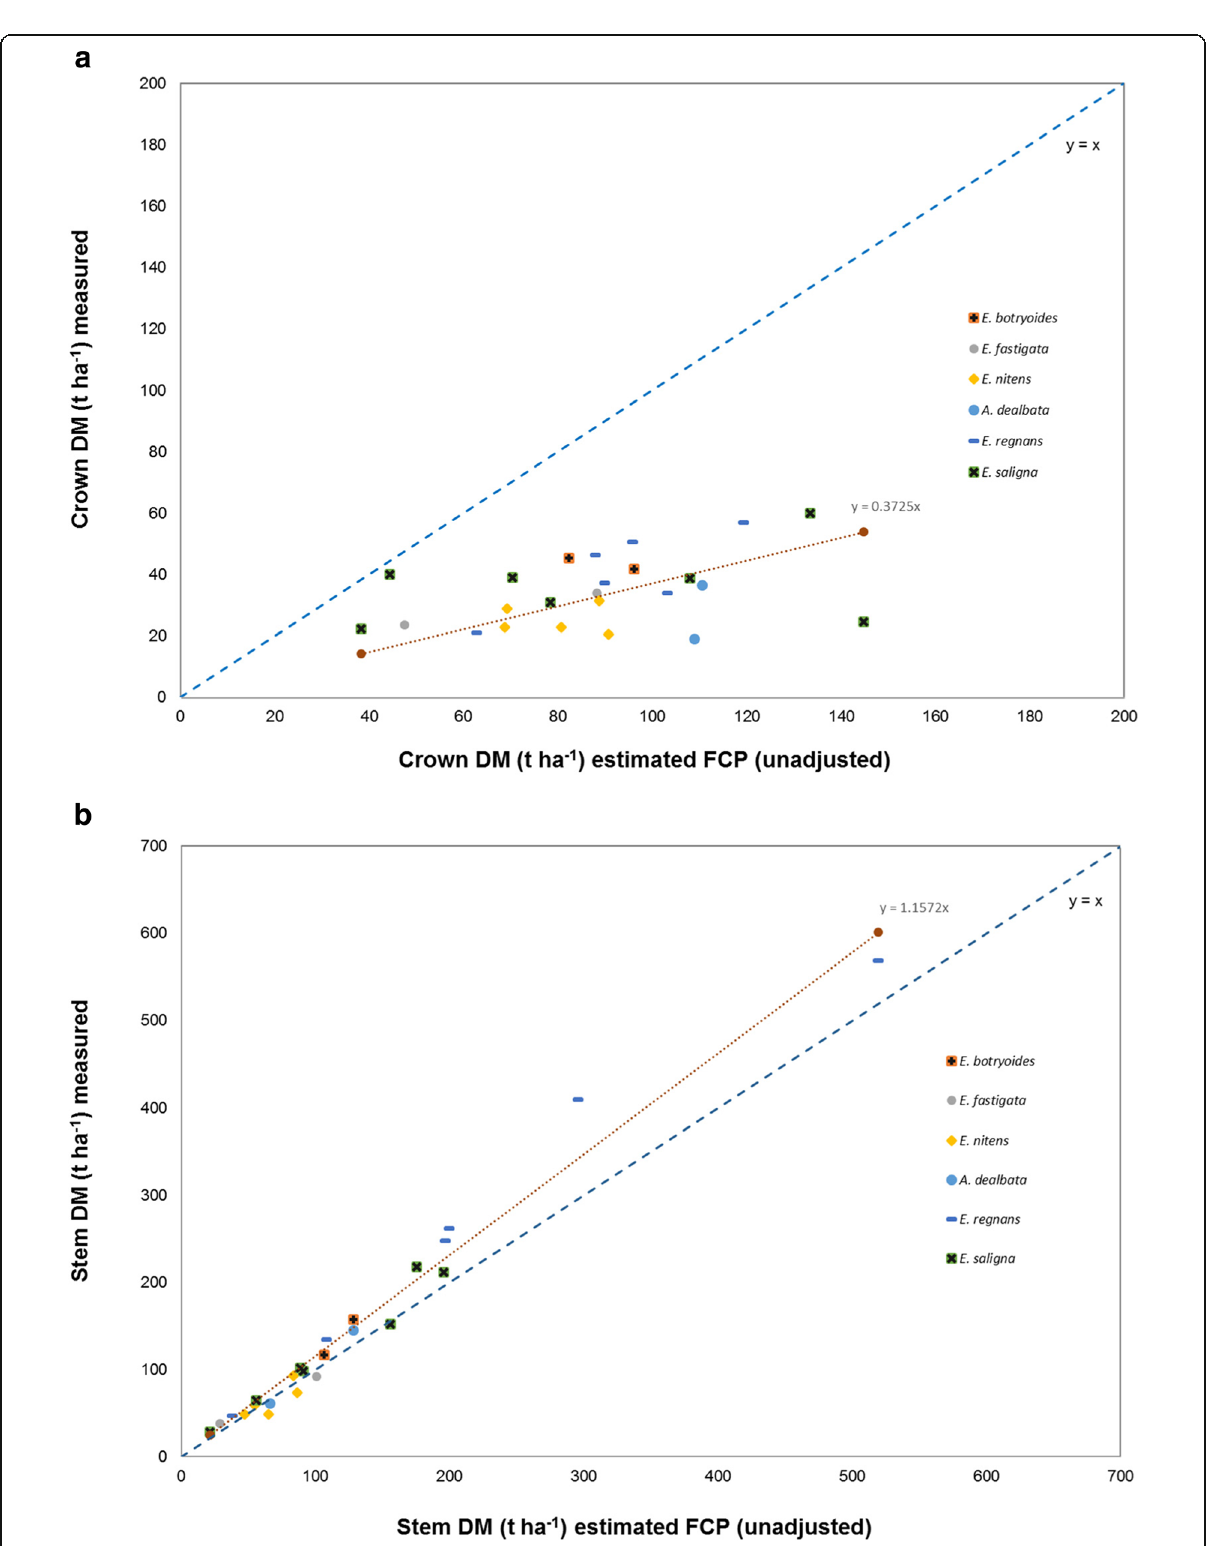
Fig. 3 Relationship between measured dry matter (DM) in Eucalyptus and Acacia species and DM in stands of the same age, mean top height, basal area, stocking, and silvicultural regime estimated using the Forest Carbon Predictor (FCP) for a crown and b stem